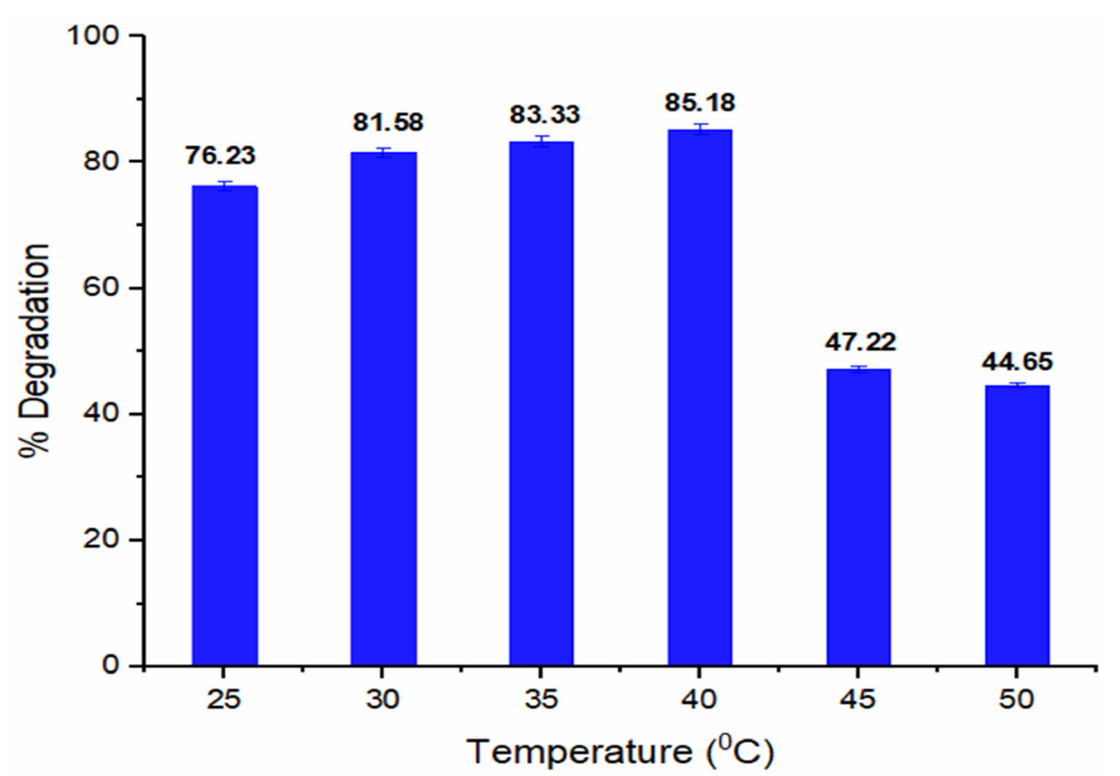
Figure 5. Effect of Temperature on % degradation of Basic Orange 2